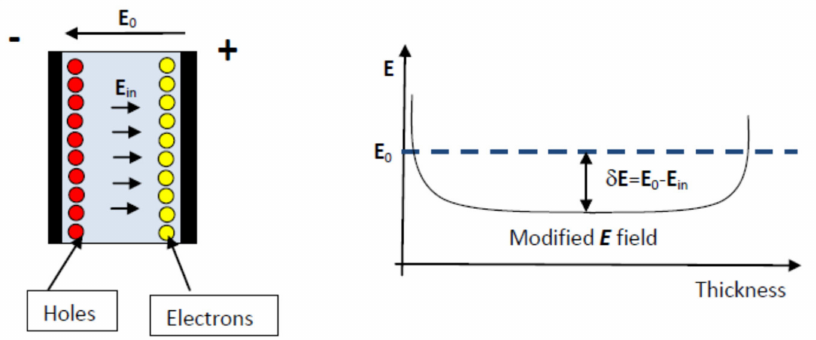
Figure 13. Schematic view of the polarization effect on the electrical